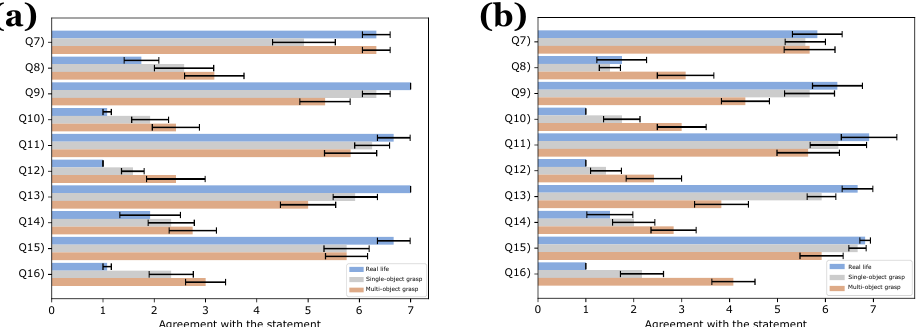
Figure 6. NASA TLX: ( a ) Desktop and Shelf scenarios; ( b ) Room scenario. Error bars indicate standard error.